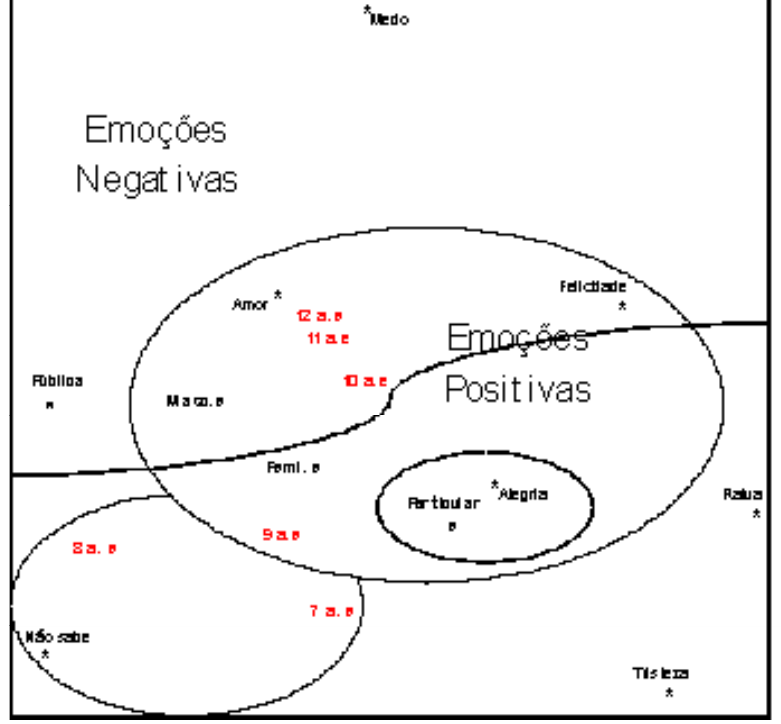
Figura 2. Análise SSA das emoções experimentadas com maior freqüência (Questão 2) considerando como variáveis externas (e) tipo de escola, sexo e faixa etária Nota. Projeção tridimensional, Coordenada 1 x 2, Coeficiente de Alienação